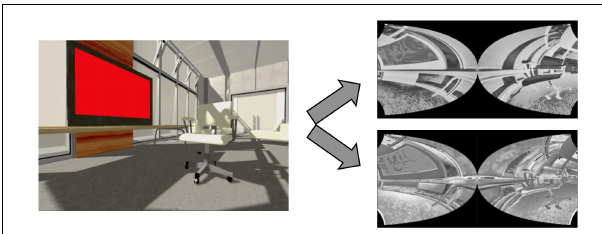
FIGURE 5 | Retina model. Left: input example. Right: associated output of the retina model (OFF-centered ganglion cells on top and ON-centered ganglion cells below). We generated these input and output images by simulating the retina model on the NRP. The ON- and OFF-centered ganglion cells react to bright and dark regions of the image, respectively, and are more active around regions of high contrast. The output images look distorted, because fewer retinal ganglion cells, whose output is represented by one pixel for each cell, encode the same portion of the visual field as the eccentricity grows. For example, the left side of the TV screen looks smaller than its right side, closer to the fovea. Note that the image on the left has been rendered by the NRP and that the real input of the retina model is not rendered. For example, the shadows are not fed to the retina model, which does not impact our experimental setup because no shadows are involved in the crowding paradigms we